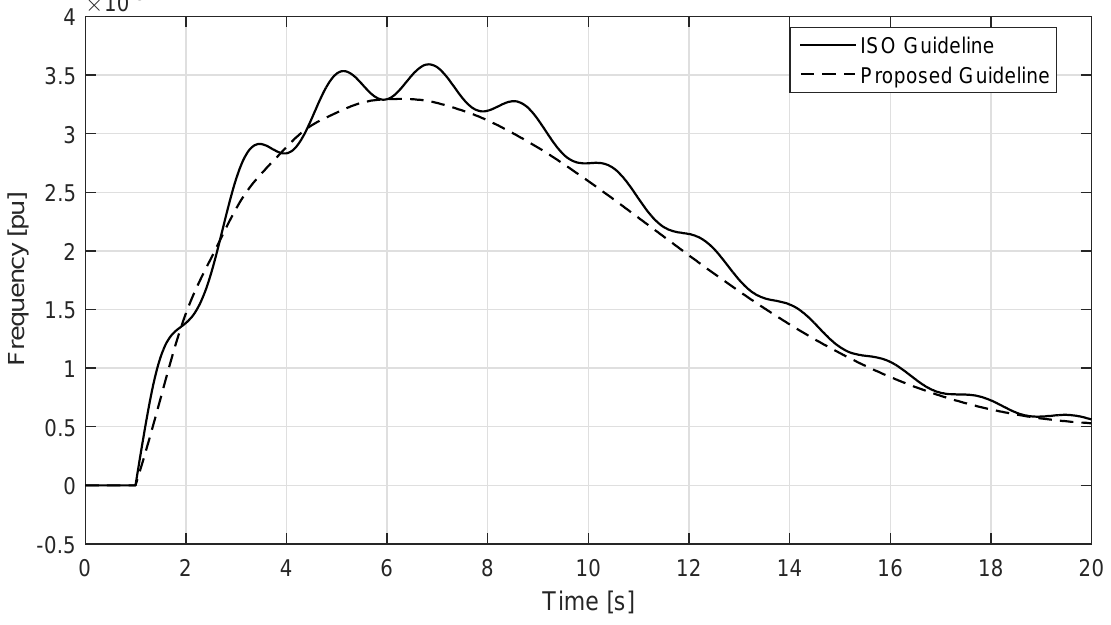
Figure 11. Frequency deviation response for the power plant at bus